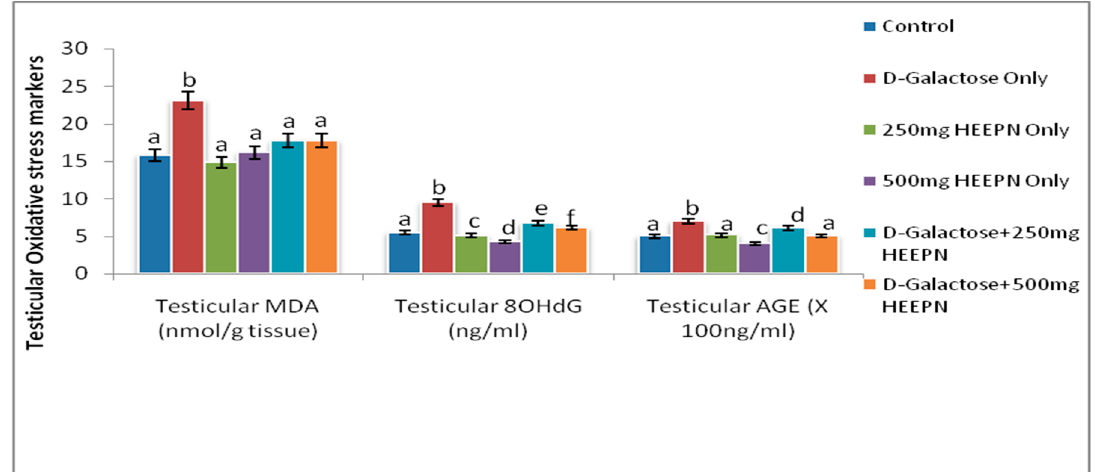
Figure 3. Effect of graded doses of HELEPN on oxidative stress biomarkers.Values are means of five replicates ± SEM. Bars carrying different superscripts (a–f) are significantly different at p < 0.05.